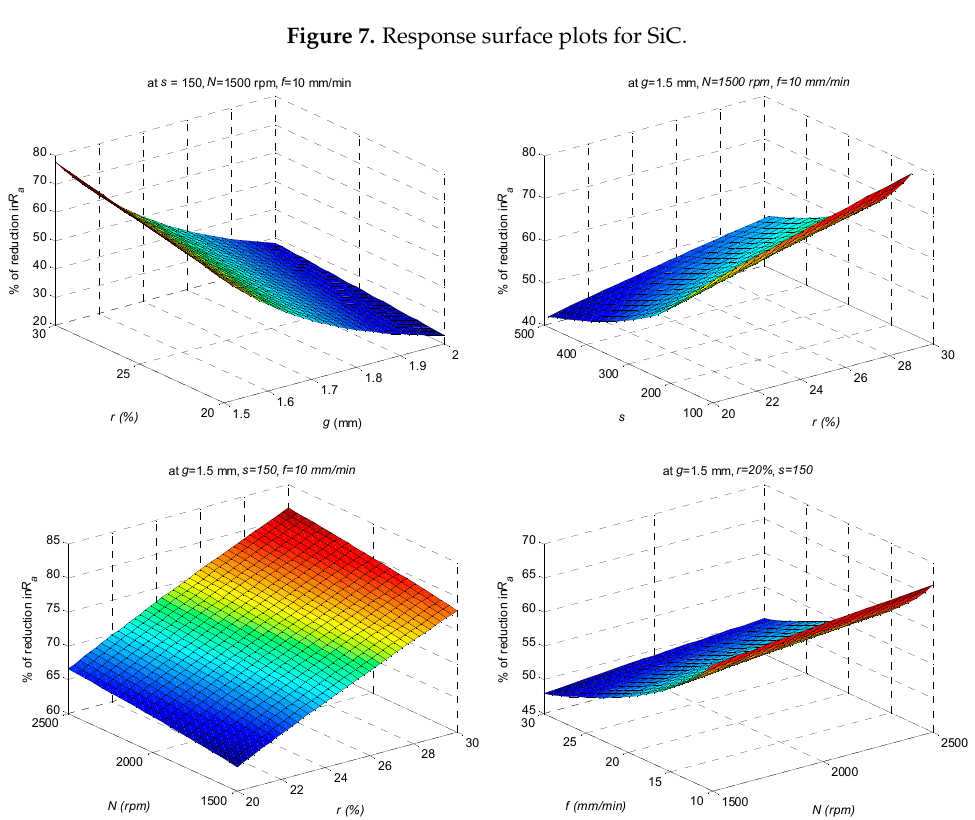
Figure 8. Response surface plots for Al 2 O 3.